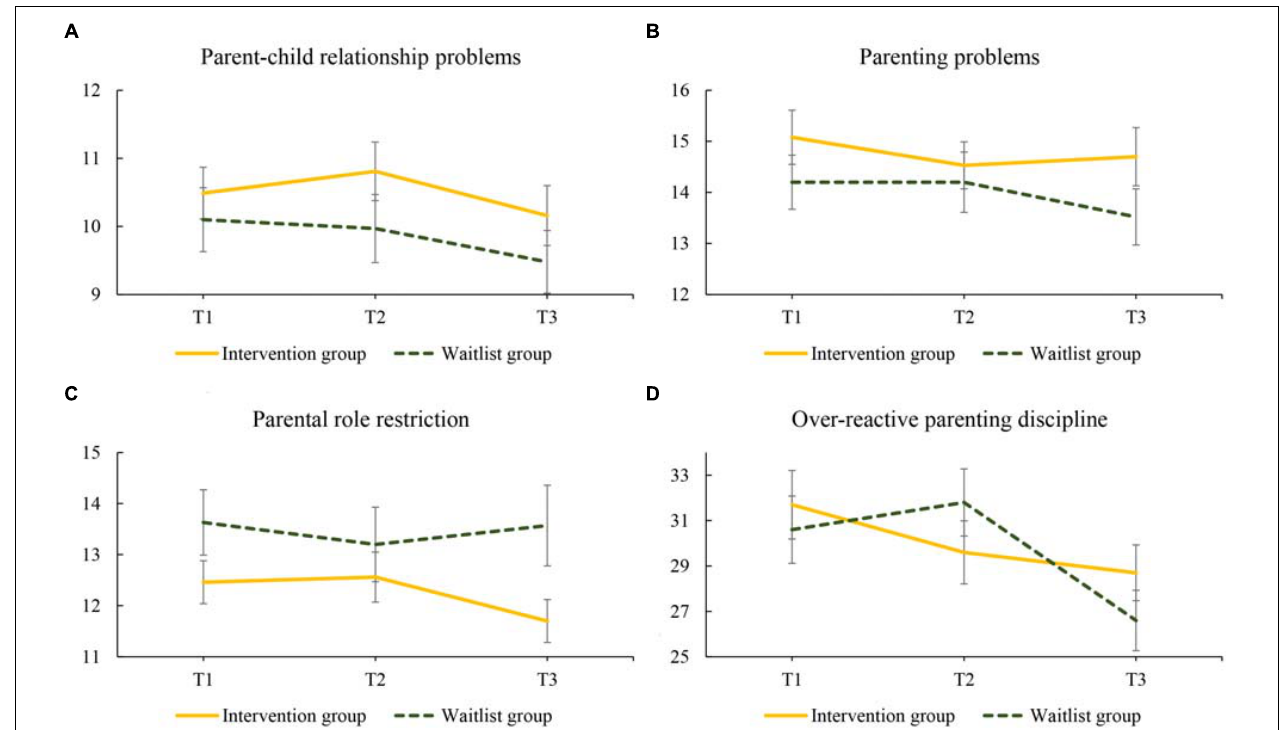
FIGURE 2 | Changes in mean scores regarding (A) parent-child relationship problems, (B) parenting problems, (C) parental role restriction, and (D) over-reactive parenting discipline for women in the intervention and waitlist group over the 20-week study period: T1 to T2 (0–10 weeks) and T2 to T3 (10–20 weeks). Intervention group assessments: T1, pretest; T2, posttest; T3, follow-up; Waitlist group assessment: T1, waitlist; T2, pretest; T3